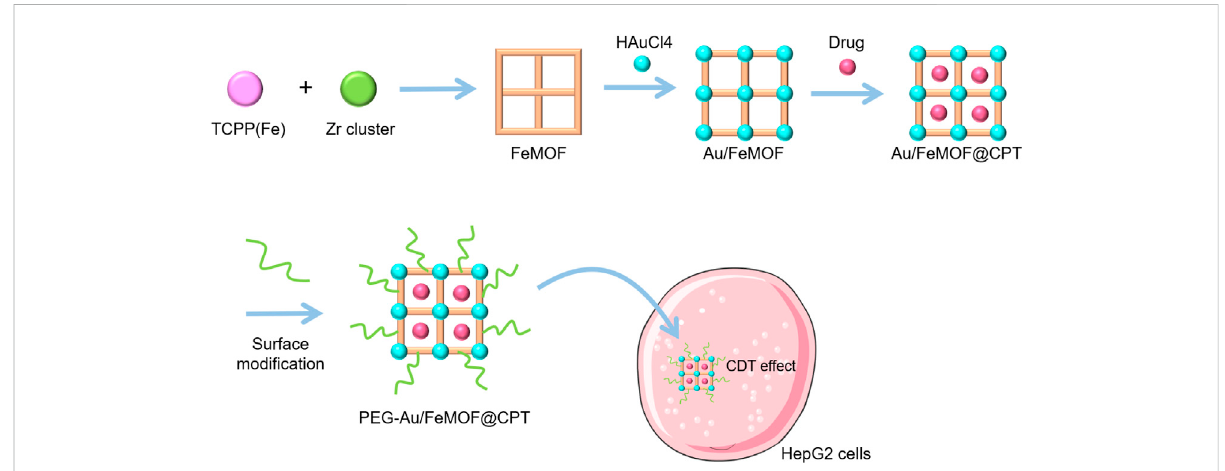
FIGURE 3 Synthesis and application of PEG-Au/FeMOF@CPT NPs. The schematic pieces were provided by Smart Medical Art and adapted [http://www. servier.com]. Servier Medical Art by Servier is licensed under a Creative Commons Attribution 3.0 Unported